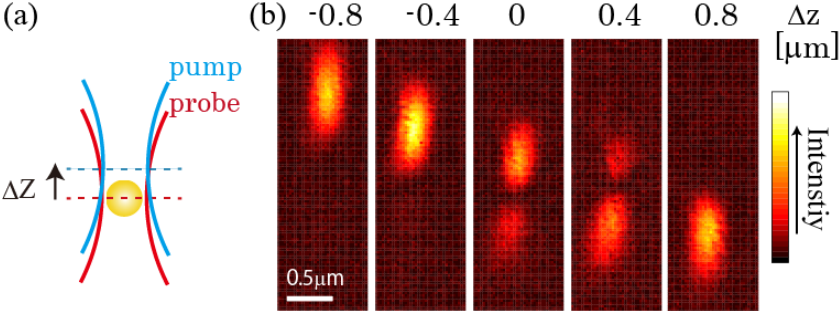
Figure 4. Spatial resolution in the axial plane: ( a ) Focal offset between the pump and probe beam at the focal. ( b ) Photothermal (PT) images of a single gold nanoparticle in the axial plane with several values of z.